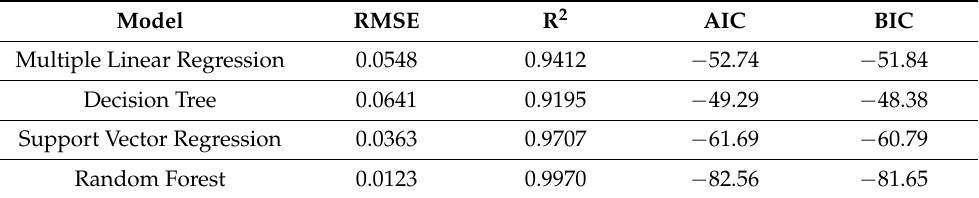
Table 4. Performance comparison of machine learning models for external